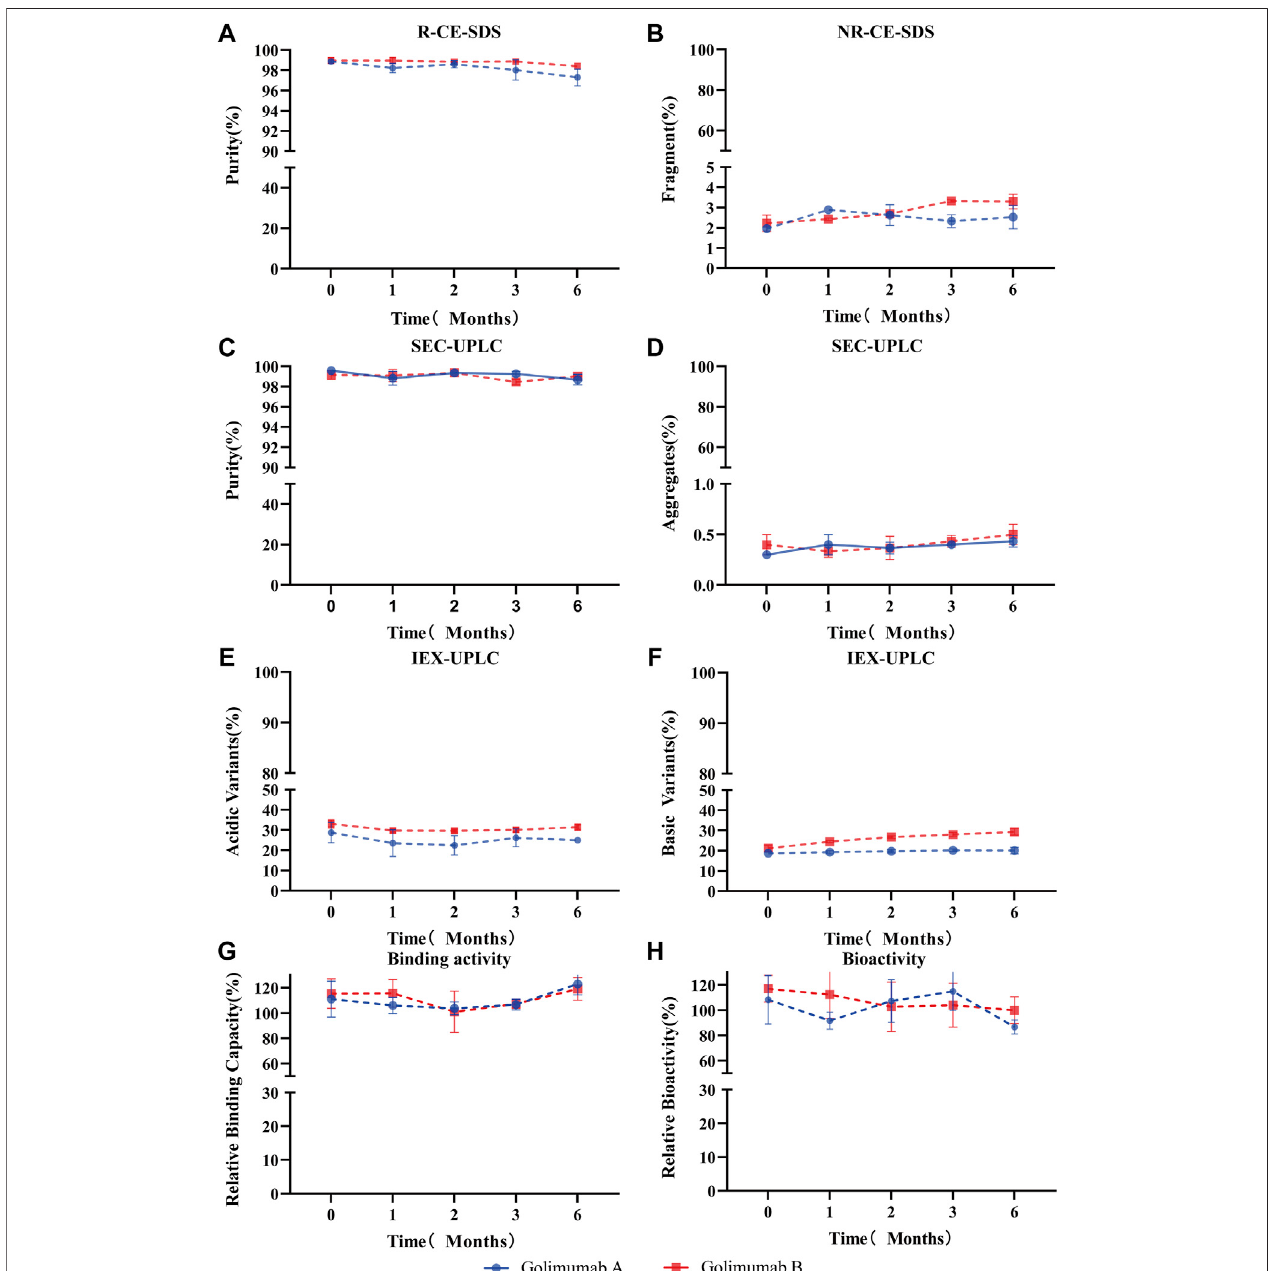
FIGURE7| AcceleratedstabilityevaluationofAsumodi fi cationwithhighabundanceingolimumab.AcceleratedstabilitysampleswereanalyzedusingR(reduced)- CE-SDS (A) ,NR(non-reduced)-CE-SDS (B) ,SEC-UPLC[purity: (C) ,aggregates (D) ],IEX[acidicvariants (E) ,basicvariants (F) ],bindingactivity (G) ,andbioactivity (H) at 25 ° C at the (0, 1, 2, 3, and 6) month time